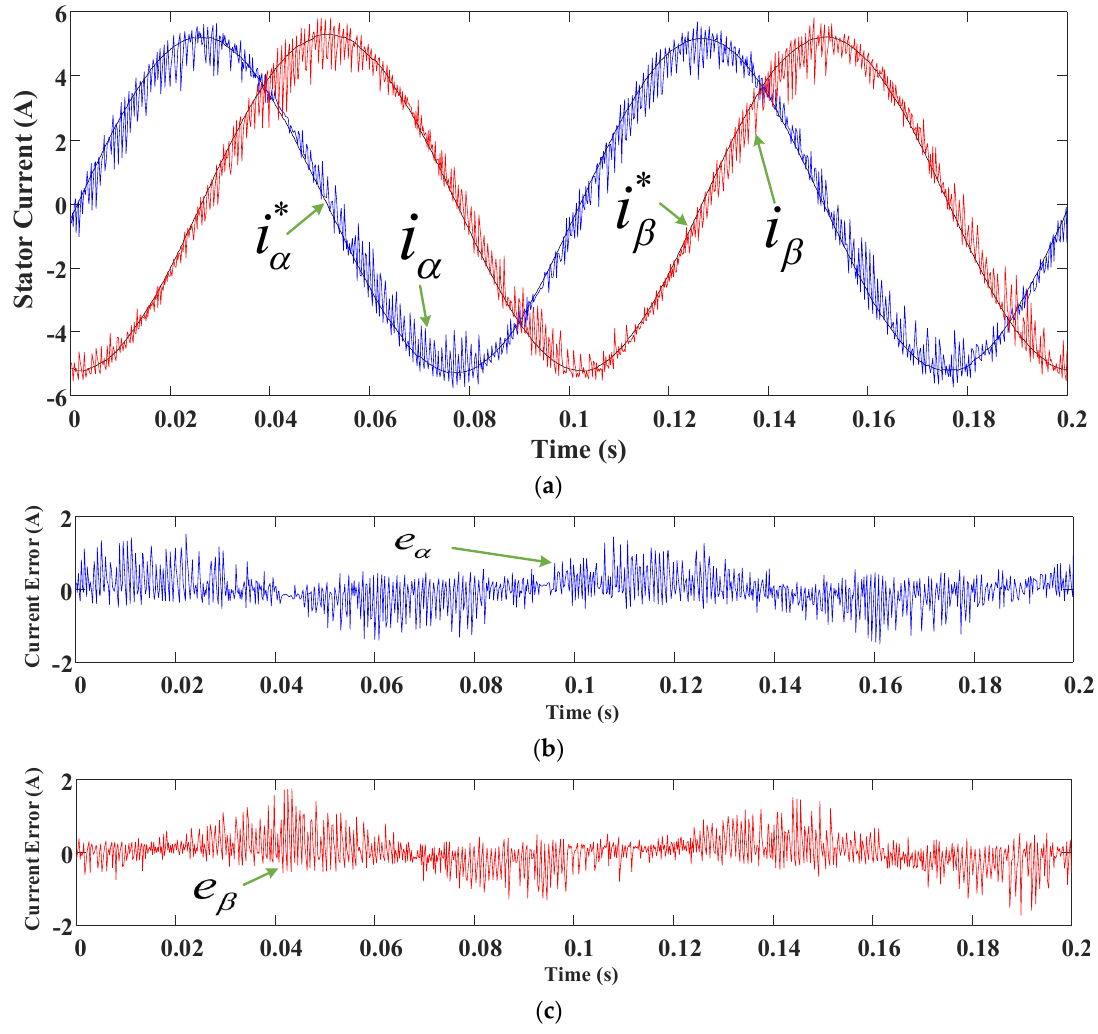
Figure 9. Experimental results of DVV-MPCC under speed 300 rpm and load 2 Nm (case 1): ( a ) current responses; ( b ) α -axis current error; ( c ) β -axis current error.